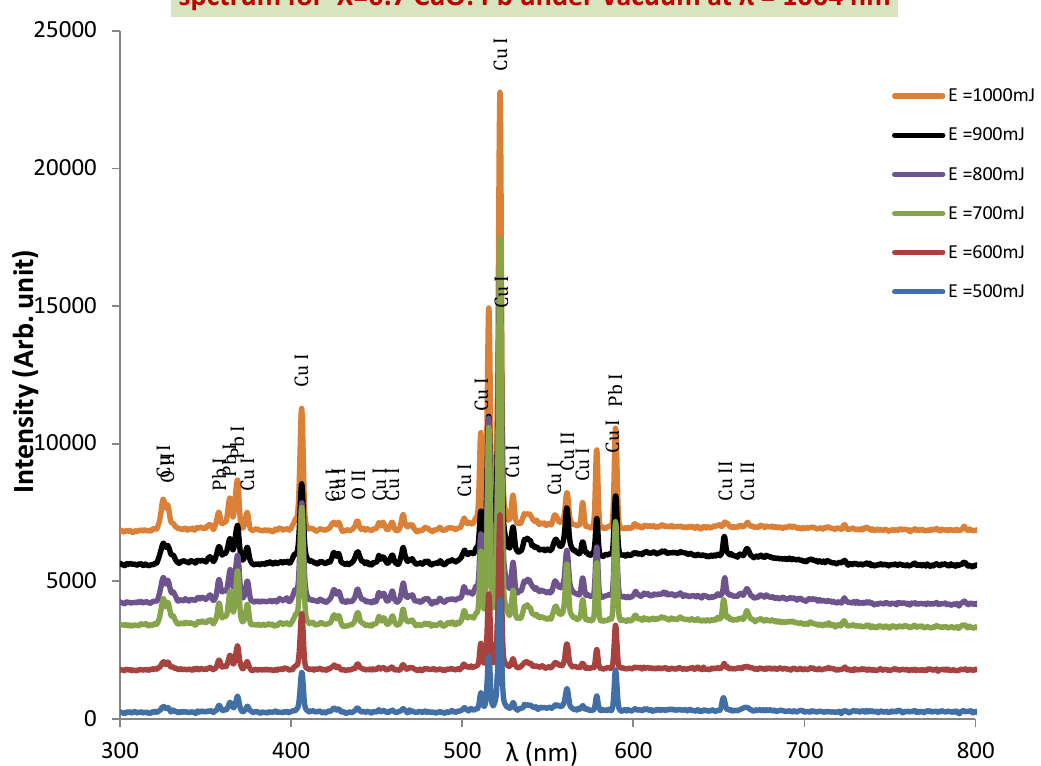
Fig. 3: Emission spectra of laser induced on CuO:Pb component at X=0.7 target in vacuum with different laser energies.